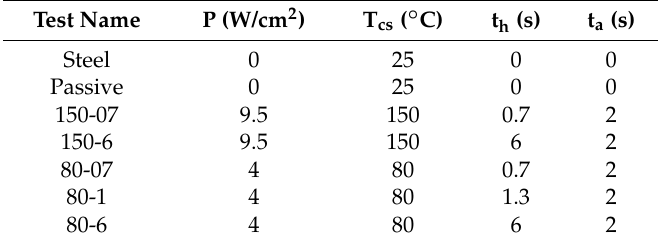
Table 1. Operating conditions of the injection molding tests. (P = electrical power density; T cs = temperature measured on the cavity surface 6 s after the melt entrance into the cavity; the activation time, t a , and the heating time, t h , represent the time during which the heating device was kept active before the first contact of the melt with the cavity surface, and the time during which the heating device was active after the contact of melt with the cavity surface,